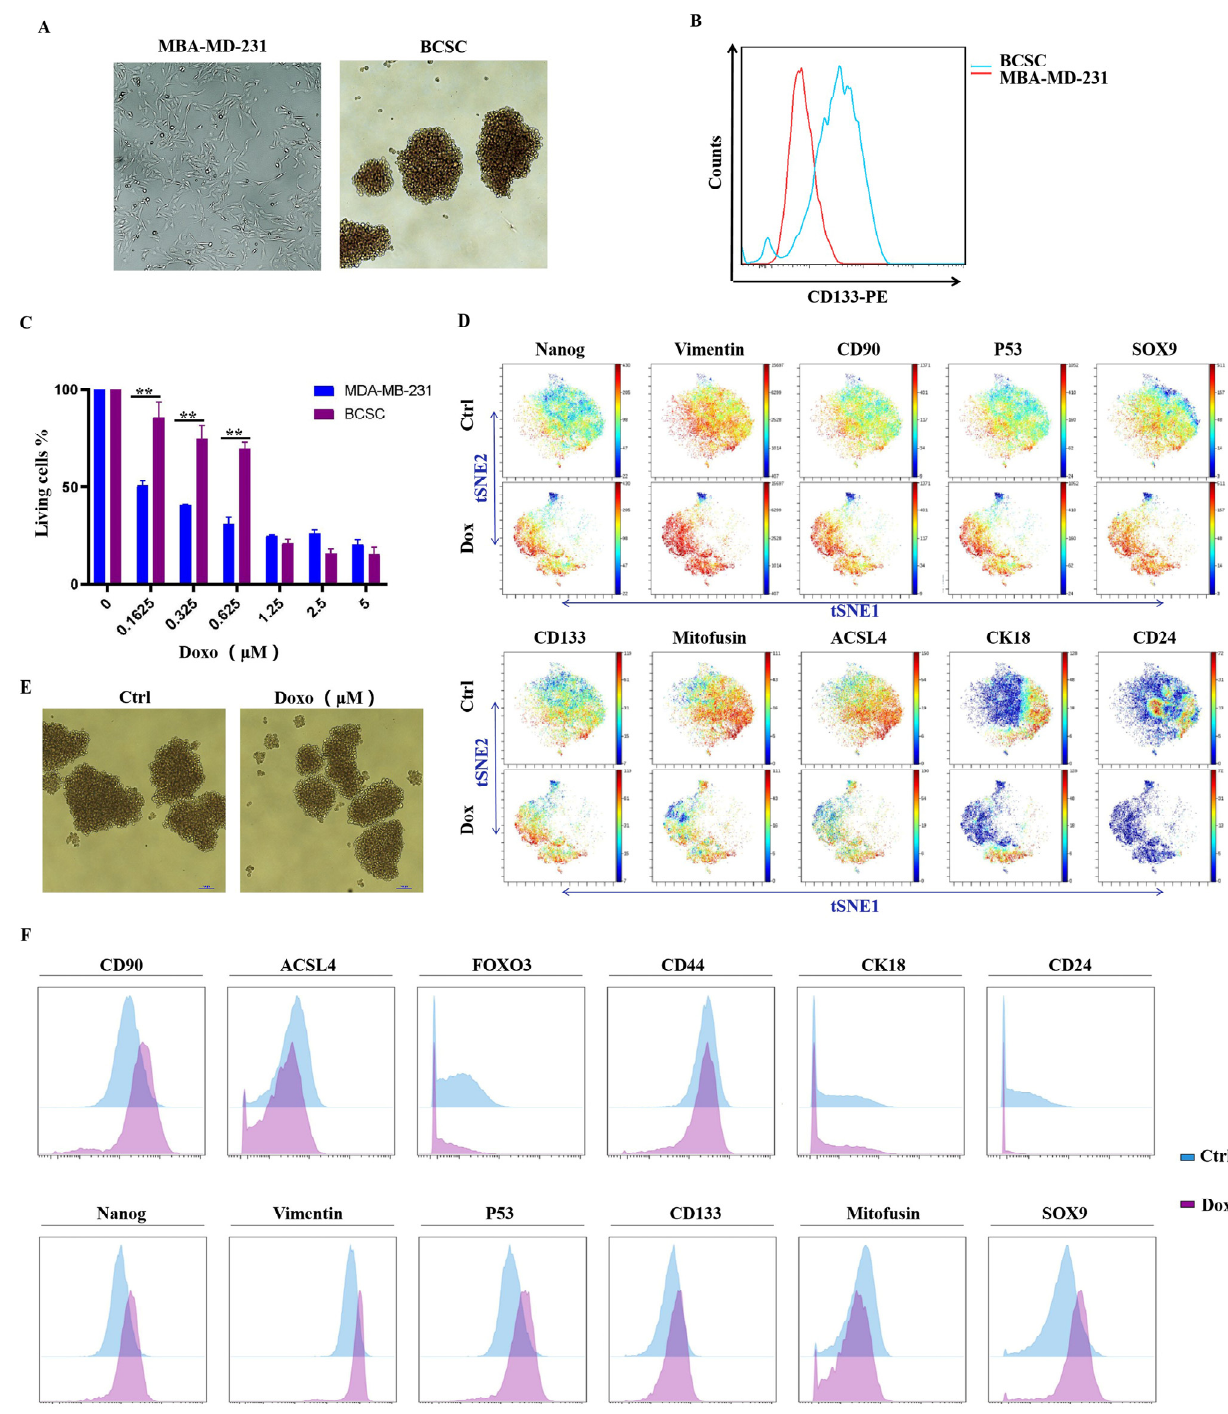
Figure 2. MDA-MB-231-derived spheroid cells were resistant to doxorubicin administration, and stem cell markers were dramatically induced. ( A ) Images of MDA-MB-231 cells and cultured spheroids. ( B ) Flow cytometry detected stemness marker CD133 expression of MDA-MB-231 cells and BCSCs. ( C ) CCK8 assay analysis showed anti-proliferation of doxorubicin against MDA-MB-231 cells and MDA-MB-231-derived spheroid cells. ( D ) t-SNE plot cluster distribution, and protein markers including CD133, CD90, vimentin, Nanog, Sox9, CK18, and CD24 expression of spheroid cells before and after being treated with doxorubicin (blue-to-red scale, red represents high expression). ( E ) Images of cultured stem cell spheres treated with or without doxorubicin. ( F ) Protein markers’ mean expression level of BCSCs treated with or without doxorubicin. (** p < 0.01, n = 3 biologically independent samples per group).